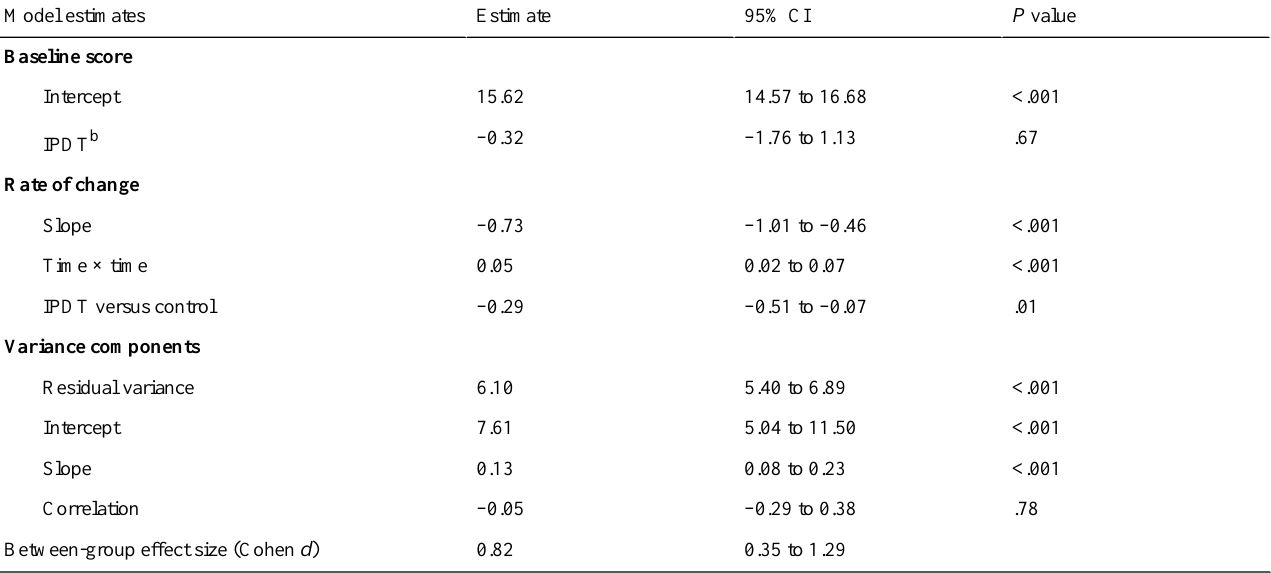
Table 2. Multilevel models estimating changes over time in the primary outcome measure, QIDS-A17-SR a .